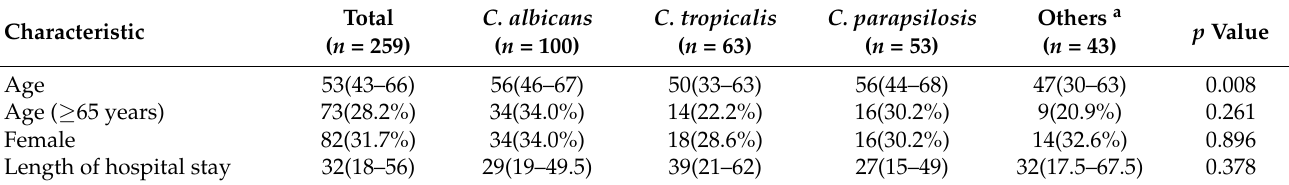
Table 2. Baseline characteristics of patients with C. albicans and NAC